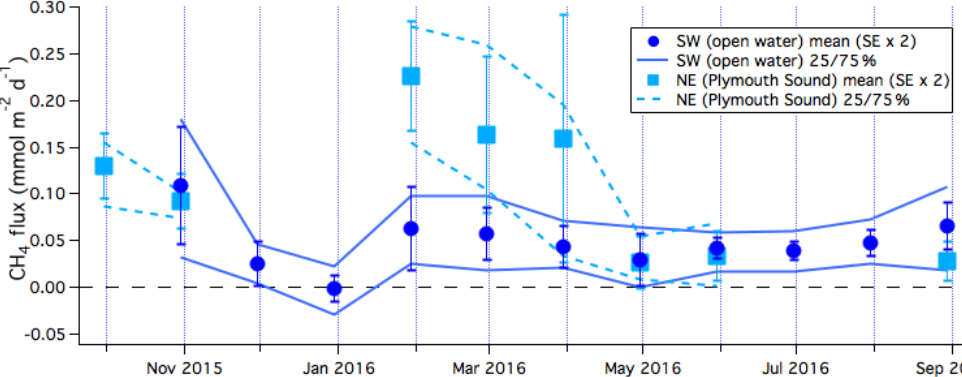
Figure 2. Monthly averages and 25th and 75th percentiles (designated 25/75% in the figure) of CH 4 flux from the southwest (open water) and northeast (Plymouth Sound) wind sectors. Error bars indicate 2 times standard error.